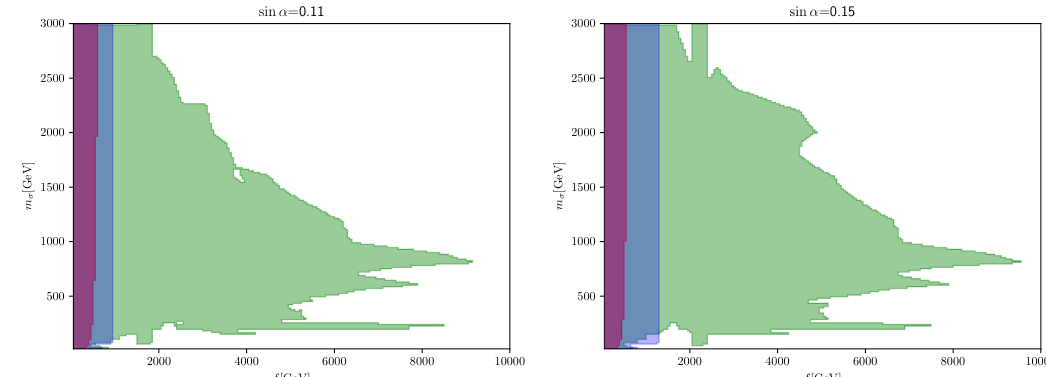
Figure 3 . Constraints on the parameter space of f and m (cid:27) for sin (cid:11) = 0 : 11 (left) and sin (cid:11) = 0 : 15 (right) with a ‘gauge invariant’ treatment of the dilaton-Higgs mixing. The colour coding is the same as for (cid:12)gure